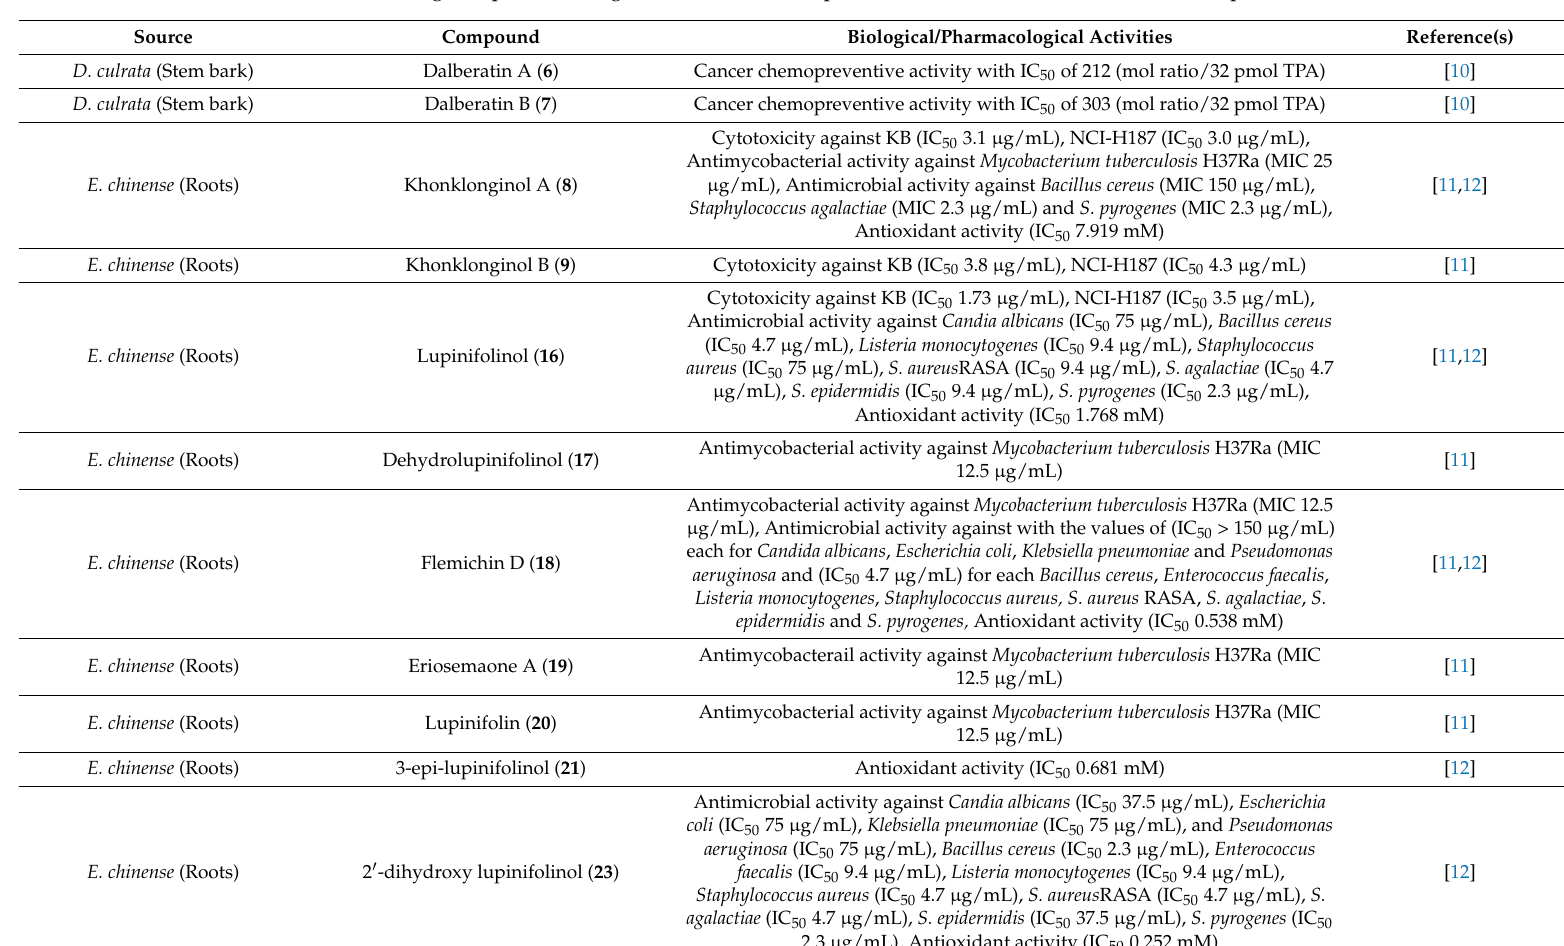
Table 2. Biological/pharmacological activities of compounds isolated from selected medicinal